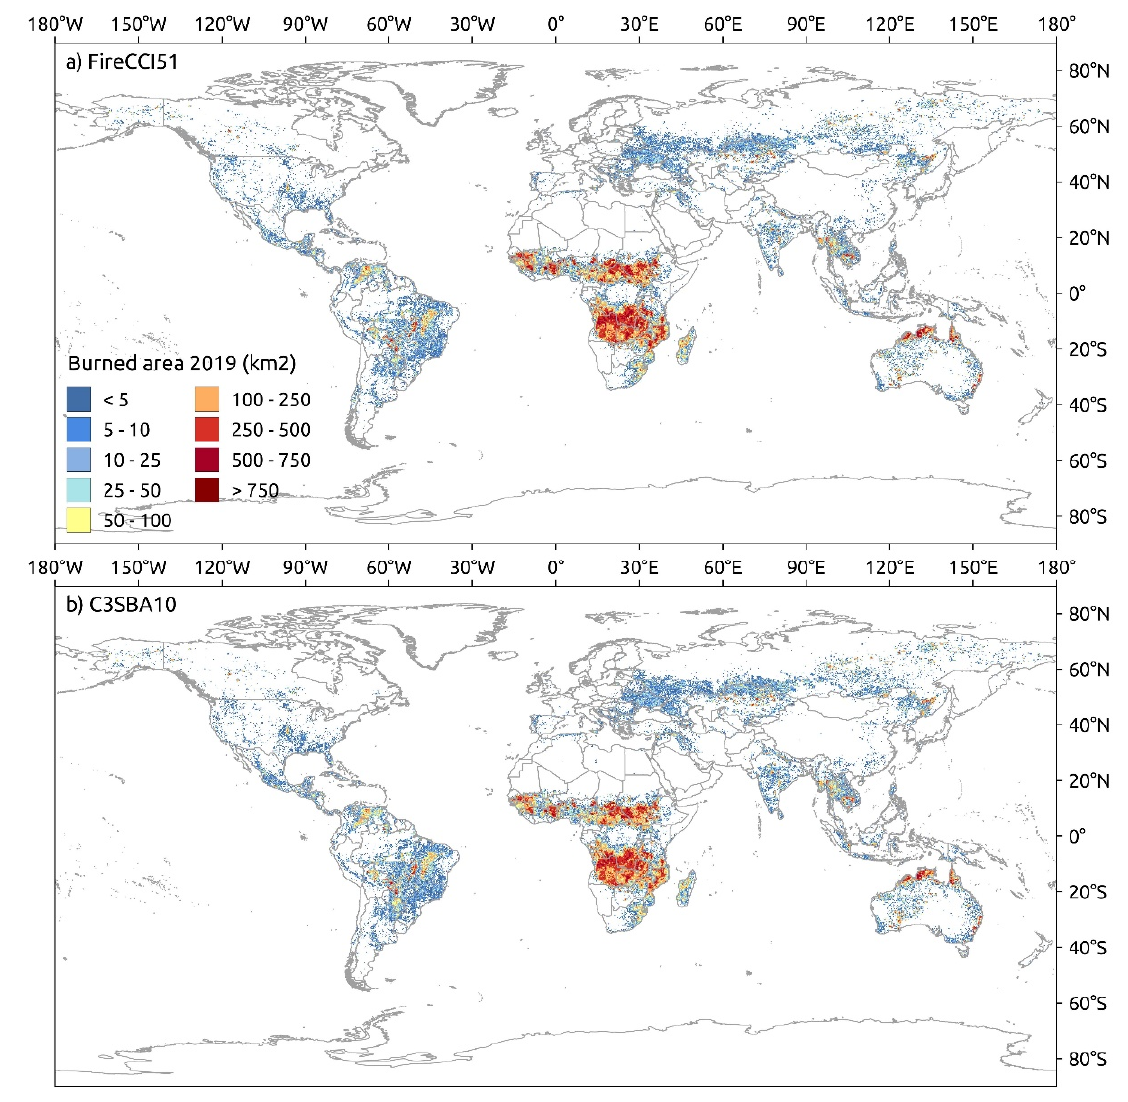
Figure 5. FireCCI51 ( a ) and C3SBA10 ( b ) annual accumulated BA for the year 2019 at 0.25° spatial resolution. Table 3. Burned area per biome derived from the C3SBA10 product, and relative differences against the predecessor global BA product FireCCI51.